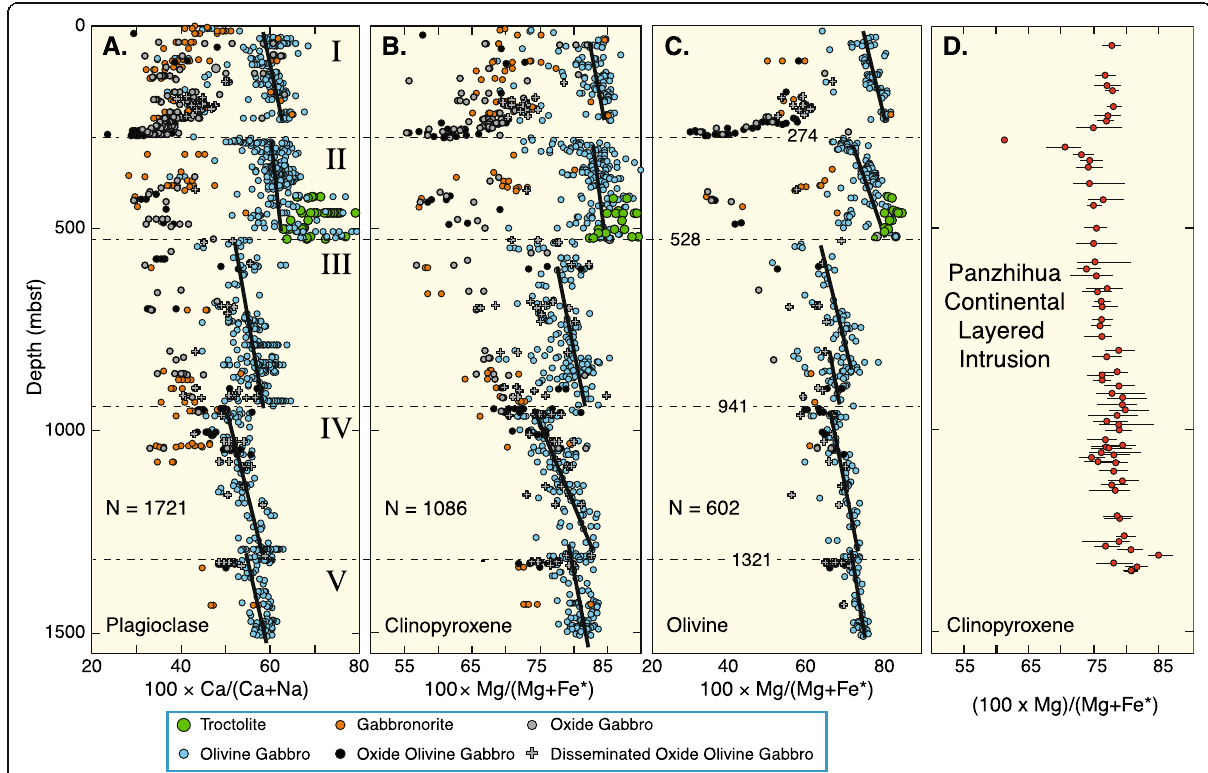
Fig. 15 a – c Down-hole mineral composition plots for Hole 735B plagioclase anorthite content, augite Mg#, and olivine forsterite content modified from Dick et al. (2002) subdivided by major lithologic groups I to V defined by obvious breaks in the composition of the olivine gabbros. Points represent analytical averages for individual mineral grains. Heavy solid lines are inferred fractionation trends for the olivine gabbros. d Stratigraphic variation of average augite compositions in the Permian Panzhihua layered gabbro intrusion of SW China (Pang et al. 2009). Solid thin lines show the compositional range for each data